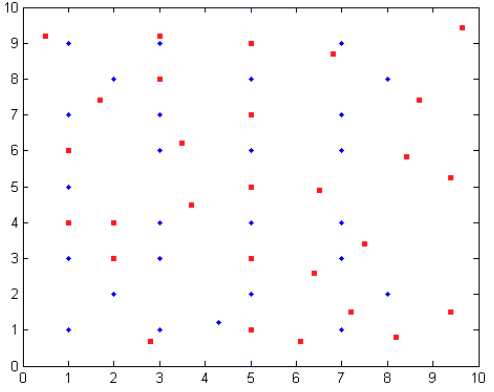
Figure 13. One of the simulation location area distribution maps. Sensors 2016 , 16 , 1934